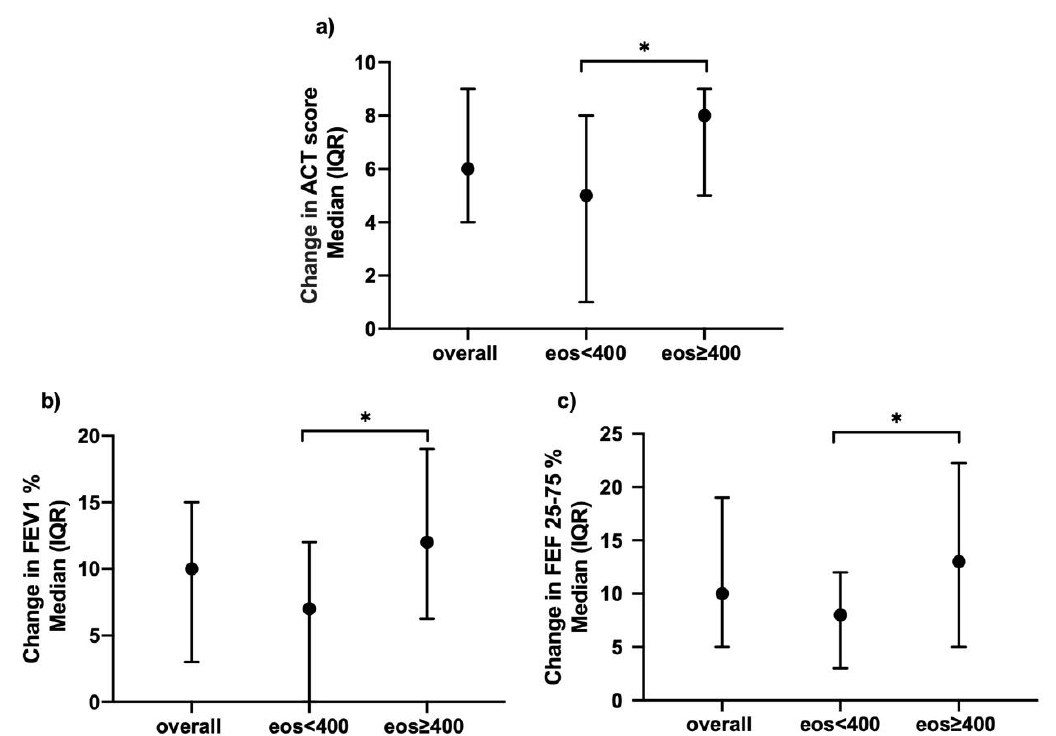
Figure 6. Effects of mepolizumab on ( a ) ACT; ( b ) FEV1%; ( c ) FEF25-75%, clustered upon level of blood eosinophilia, after 12 months of treatment (*: p < 0.05).